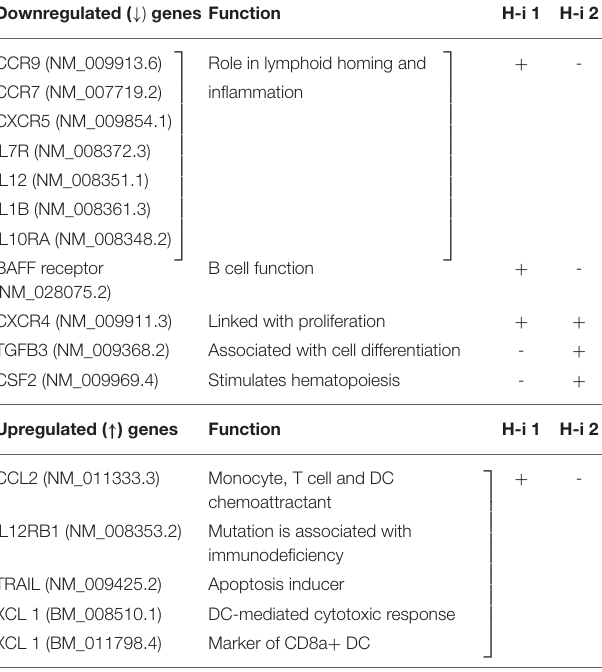
TABLE 2 | Cytokine-Cytokine receptor interaction: significantly up-/down regulated relative to baseline, + , more prominently down- or up regulated; -, less